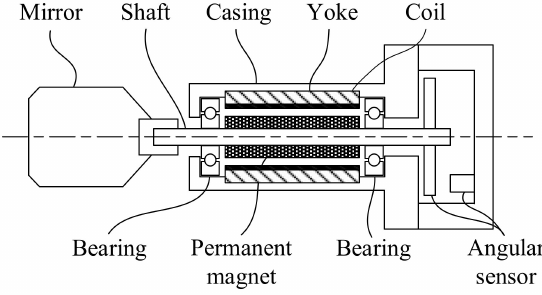
Figure 2. Illustration of analyzed coreless PM motor. Table 1. PM motor